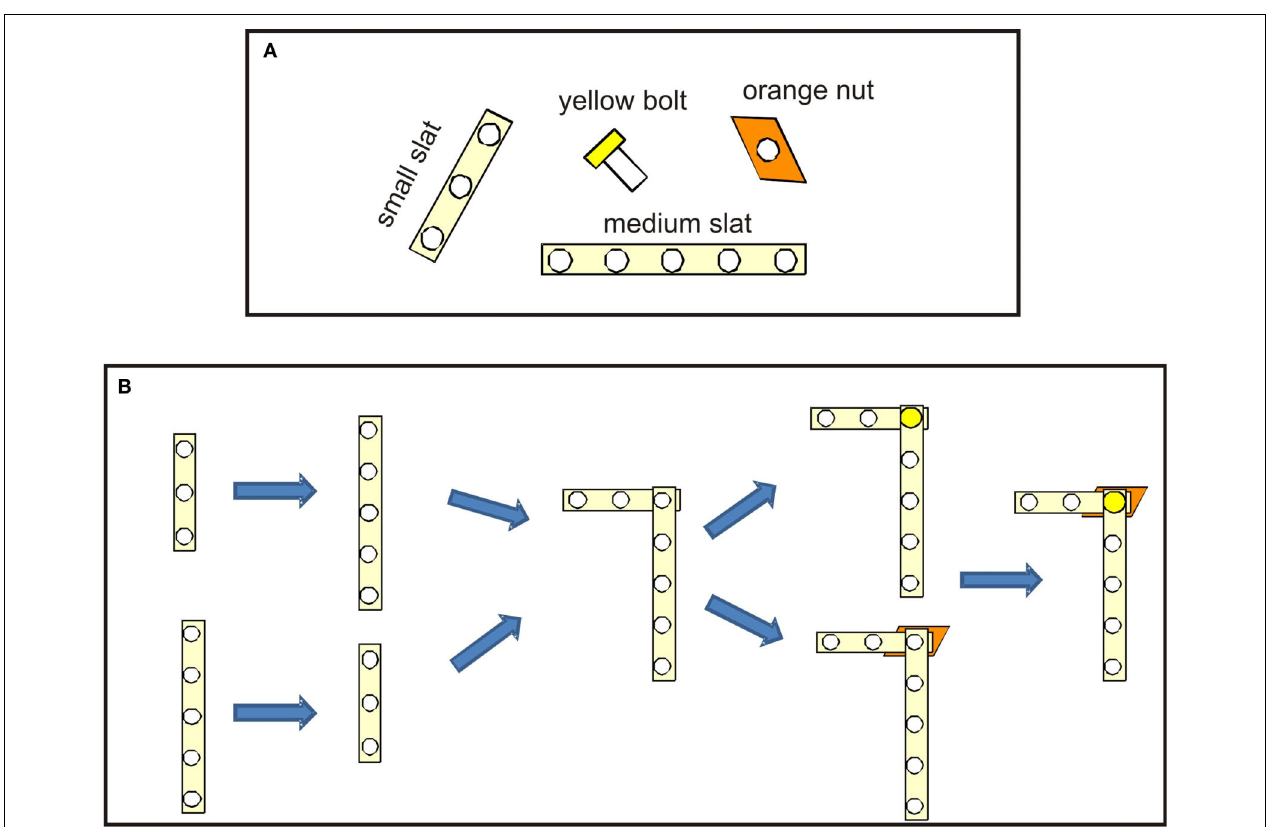
FIGURE 3 | Toy object L-shape. (A) Pieces used to build the L-shape. (B) Different serial orders to assemble the